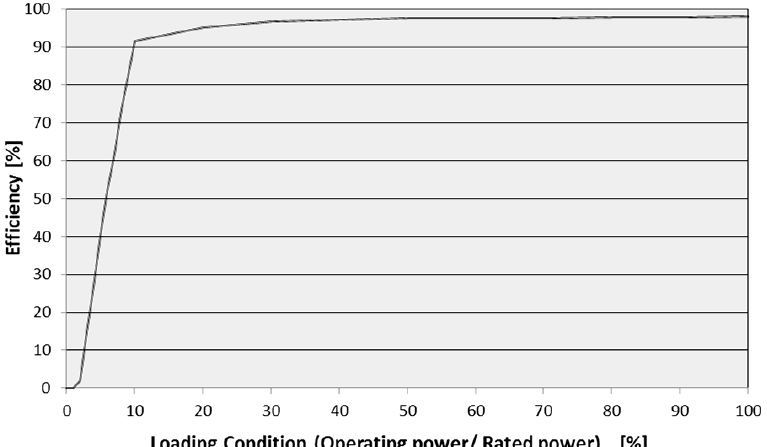
Figure 4. Converter efficiency according to the loading